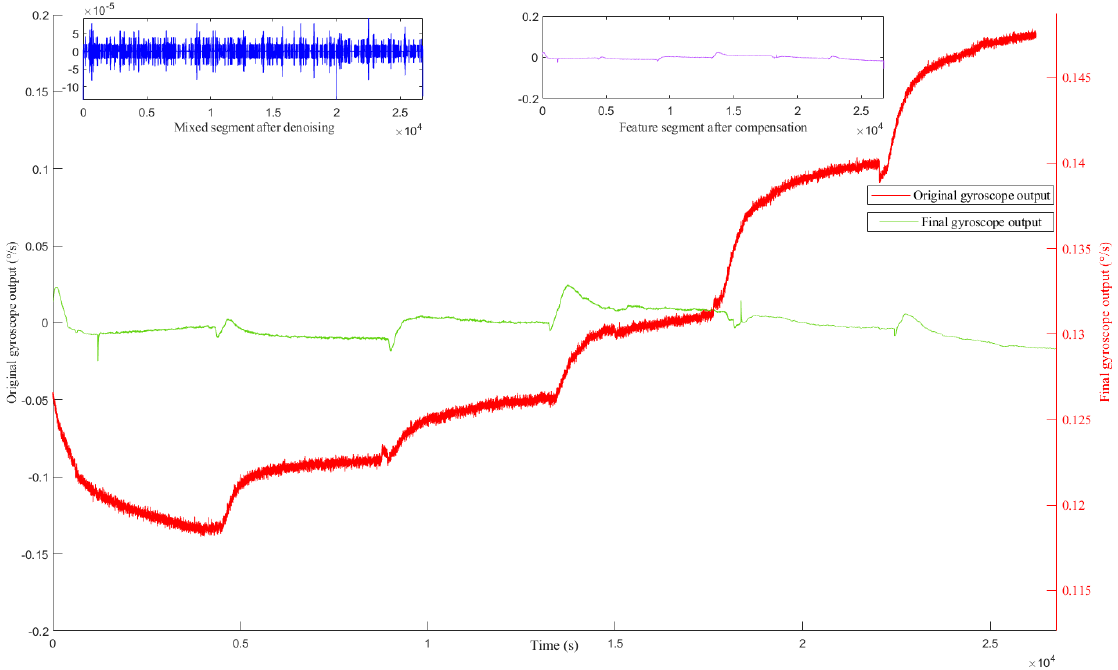
Figure 18. The final gyroscope output signal after denoising and compensation.